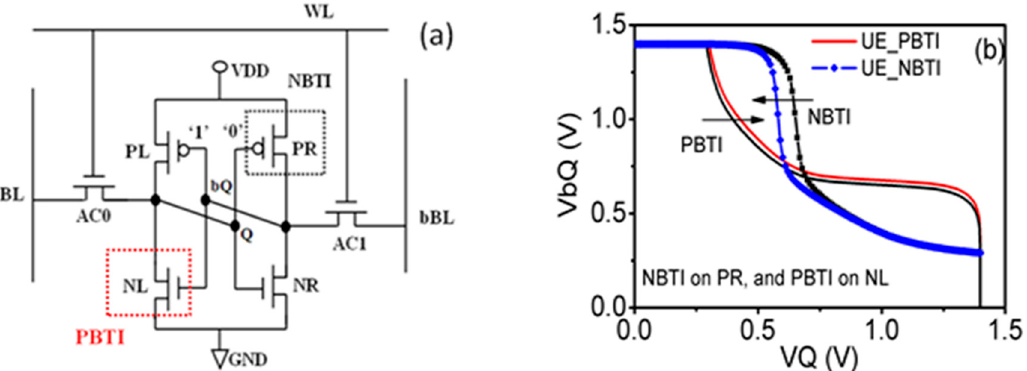
Figure 34. ( a ) When a SRAM cell holds a data bit, PBTI occurs in one of the pull-down nMOSFETs, while NBTI happens in the pull-up pMOSFET of the opposite inverters; ( b ) both PBTI and NBTI contribute to the reduction in the static noise margin (i.e., the size of butterfly eyes) by making the two inverters imbalance [29].